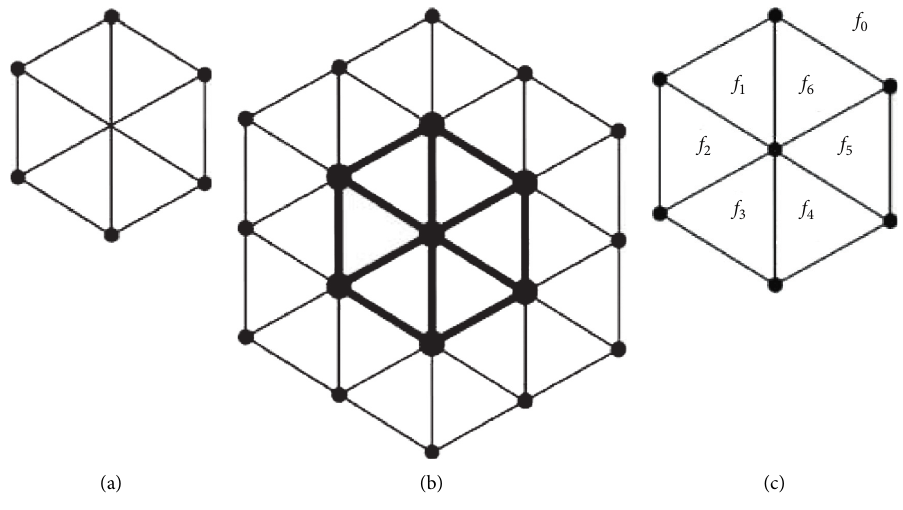
Figure 1: Hexagonal meshes.